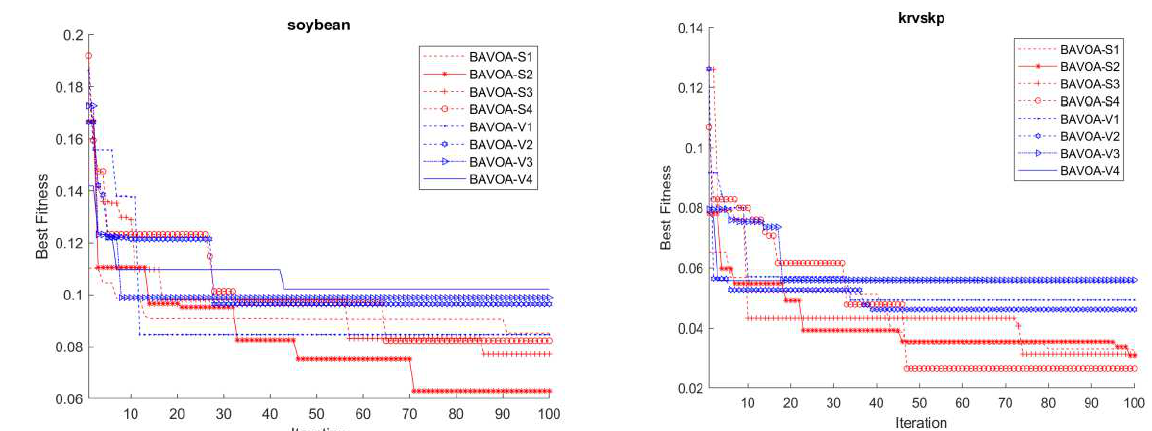
Figure 12. Comparison of the convergence of S-shaped- and V-shaped-based methods on the third six data sets .